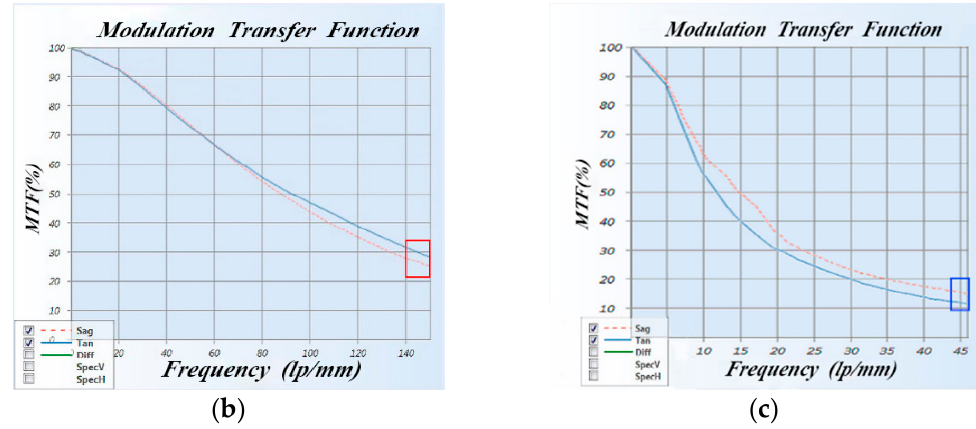
Figure 10. ( a ) MTF test principle prototype. ( b ) the MTF result of the rear-polarization system. ( c ) the MTF result of the fore-infrared system.